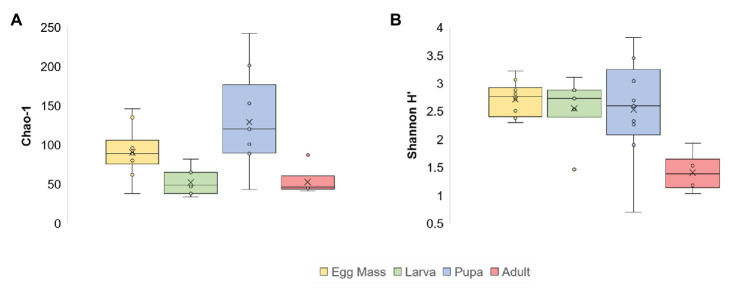
Alpha diversity of C. transvaalensis microbiota for each metamorphosis life stage [at the Amplicon Sequence Variant (ASV) level]. (A) Chao1 richness estimator; (B) Shannon H' Index. Significant differences were found between the microbiota richness of the four life stages (Kruskal-Wallis: X23 = 14.805, p = 0.002) and specifically between the pupae and the larvae and the pupae and the adults (Mann–Whitney: p = 0.003; p = 0.0076, respectively). The Shannon H' Index was significantly different between the four life stages (Kruskal-Wallis: X23 = 11.245, p = 0.01) and specifically between the egg masses and the adults and the larvae and the adults (Mann–Whitney: p = 0.00025; p = 0.0081, respectively). Egg masses: yellow; larvae: green; pupae: blue; adults: red.